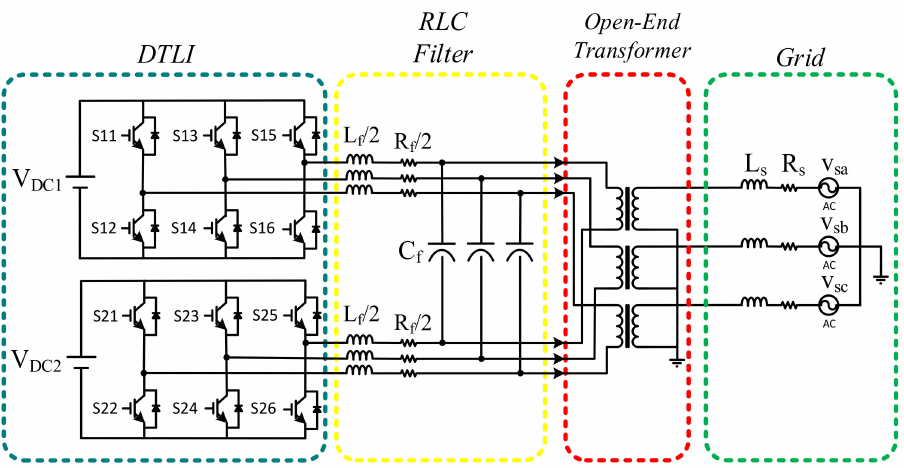
Figure 1. Dual two-level voltage source inverter (DTL VSI) topology with the common capacitor type (CCT)